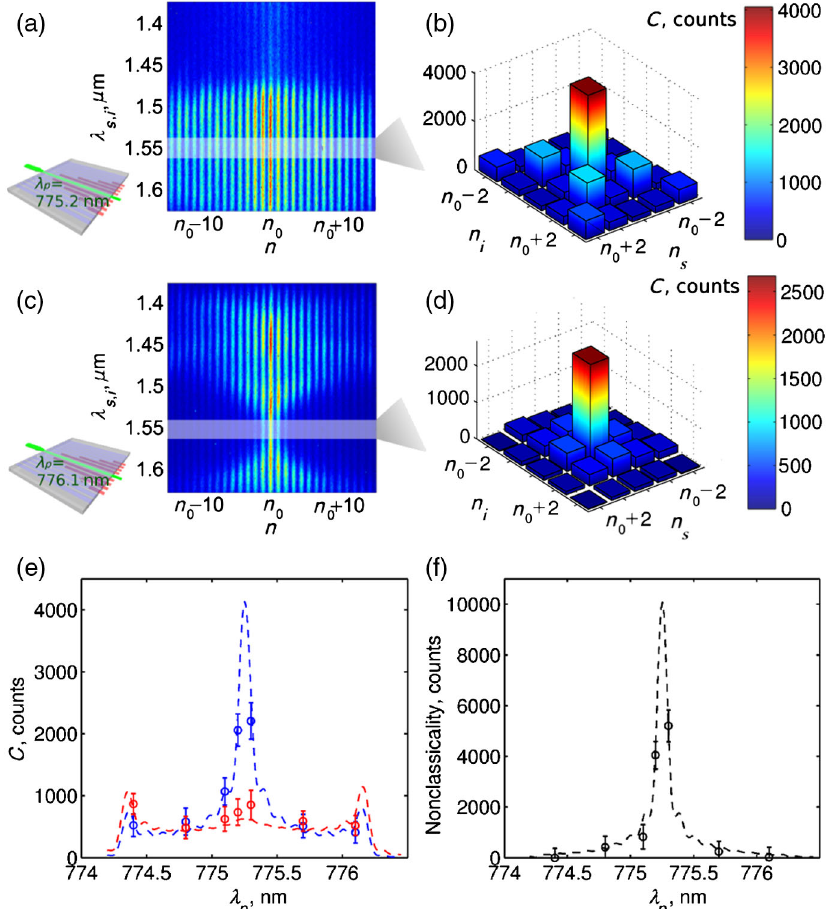
FIG. 2. (a),(c) Spatial-spectral photon-pair output distributions and (b),(d) corresponding correlations using a spectral filter (gray area). The pump beam is coupled to a waveguide at the center of the array ( n p ¼ n 0 ) with the pump wavelength (a),(b) λ p ¼ 775 . 2 nm and (c), (d) λ p ¼ 776 . 1 nm. The long-wavelength part of the spectrum is not recorded due to a lack of sensitivity of the InGaAs camera. (e) Diagonal correlations characterizing simultaneous bunching and antibunching f n 0 − 1 ;n 0 − 1 gþf n 0 − 1 ;n 0 þ 1 gþf n 0 þ 1 ;n 0 − 1 gþ f n 0 þ 1 ;n 0 þ 1 g (blue) and off-diagonal correlations f n 0 ; n 0 − 1 g þ f n 0 − 1 ; n 0 g þ f n 0 þ 1 ; n 0 g þ f n 0 ; n 0 þ 1 g (red) versus the pump wavelength λ p : theory (dashed lines) and experiment (circles with error bars). (f) Total nonclassicality versus the pump wavelength λ p : theory (dashed lines) and experiment (circles with error